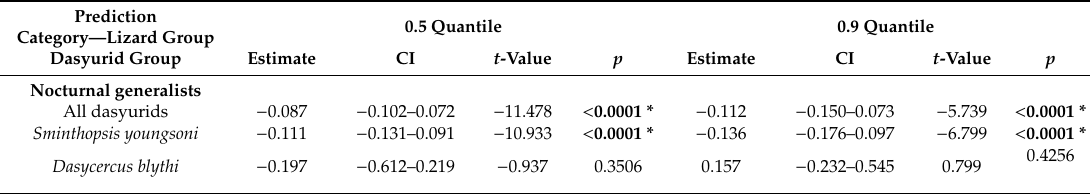
Figure 2. Relationships between lizard diet breadth and dasyurid abundance (all species) at the 0.5 (solid line) and 0.9 (dashed line) quantiles for ( a ) nocturnal generalist lizards, ( b ) diurnal generalist lizards and ( c ) specialist lizards, and ( d ) mulgara ( Dasycercus blythi ) abundance and diurnal generalist lizards. Significant relationships ( p < 0.001) are shown in blue (in panel (a), both 0.5 and 0.9 quantiles are significant; and in panel (d), it is the 0.5 quantile only). Table 1. Results of quantile regression models comparing the 0.5 and 0.9 quantiles of lizard diet breadth (Brillouin index) as a function of dasyurid abundance for a suite of predictions. Prediction categories for lizard groupings are based on activity period (nocturnal or diurnal) and diet breadth (generalist vs. specialist); and for mammalian competitors are grouped by all dasyurids or separately for each of two species, the most abundant ( Sminthopsis youngsoni ) and the largest ( Dasycercus blythi ) in the dasyurid community. A significant p -value indicated by * and bold type shows that there is a non-zero slope for that